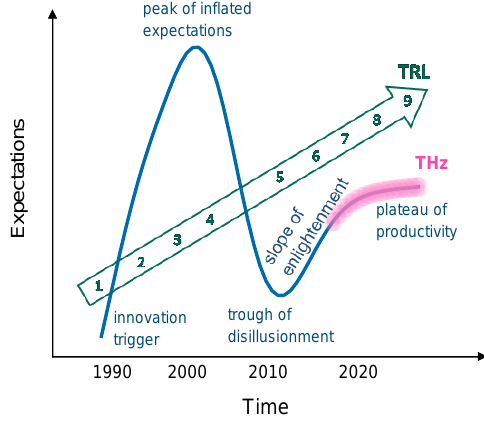
Figure 1. The Gartner Hype Cycle, TRL evolution, and the current envisaged position of THz technologies.